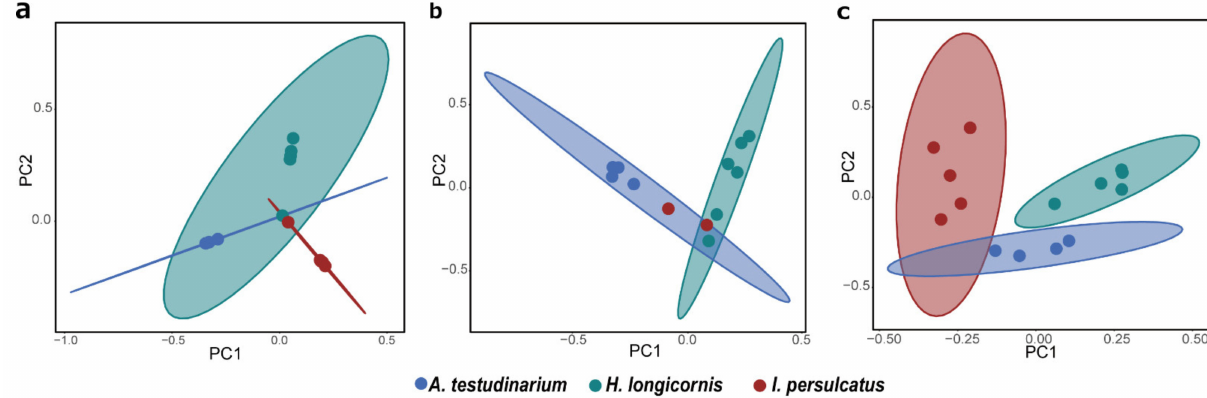
Figure 7. Principle coordinate analysis (PCoA) of eukaryotic microbiome composition in three tick species, Amblyomma testudinarium, Haemaphysalis longicornis, and Ixodes persulcatus. Arachnida (ticks) amplicon sequence variants (ASVs) were excluded, and the Jaccard diversity was calculated based on the microeukaryotic sequences using the R package phyloseq. Amplicons obtained using the TickB_PNA- and TickB_LNA-based methods (see ( a , b )) were purified with SizeSelect. For TickB_PNA, 16 samples were included, and only tick ID 3611 was filtered out owing to the low number of sequences after filtration. For TickB_LNA, 13 samples were included, and tick IDs 66, 210, 258, and 933 were filtered out owing to the low number of remaining sequences after filtration. For UNonMet-PCR ( c ), only 15 samples were included because two samples (tick IDs 66 and 2876) with 100% Acari were filtered out. Points representing the same tick species are indicated by